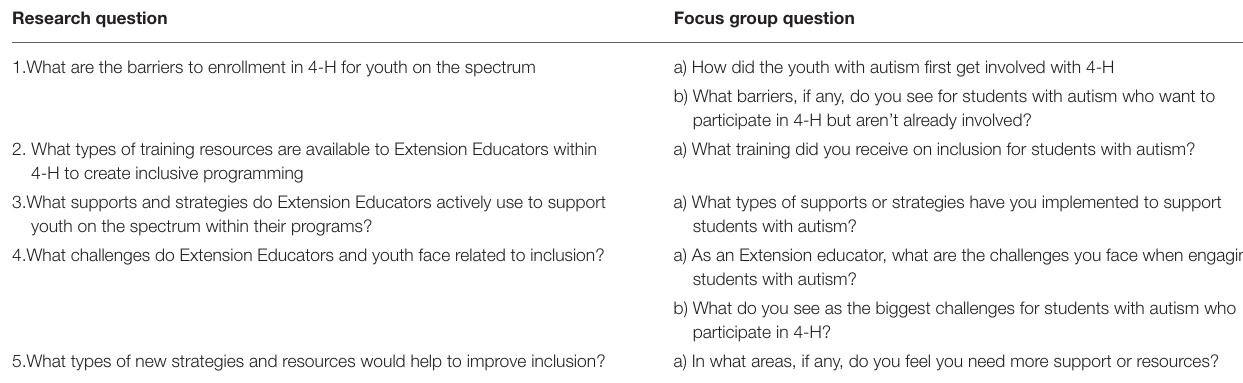
TABLE 1 | Research questions and corresponding focus group questions. Research